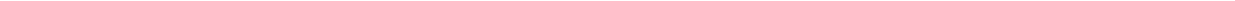
Fig. 10 Essential role of FGF10 in mediating Inh-miR-327-induced WAT browning. a Histological analysis of adipocyte morphology (H&E), adipocytes (PERI), mitochondria (COX4), and uncoupling protein (UCP1) in scWAT isolated from Inh-miR-NC- and Inh-miR-327-treated 2-week-30 °C-exposed WT and Fgf10 +/ − mice. Double-headed arrows mark the adipocyte diameter. Arrows point to respective positive signals. b – d Quanti fi cations of scWAT adipocyte size and positive signals of COX4 and UCP1 in Inh-miR-NC- and Inh-miR-327-treated 2-week-30 °C-exposed WT and Fgf10 +/ − mice ( > 30 adipocytes per fi eld; n = 10 random fi elds). e – h Western immunoblot analysis and quanti fi cation of FGF10 and UCP1 in Inh-miR-NC- and